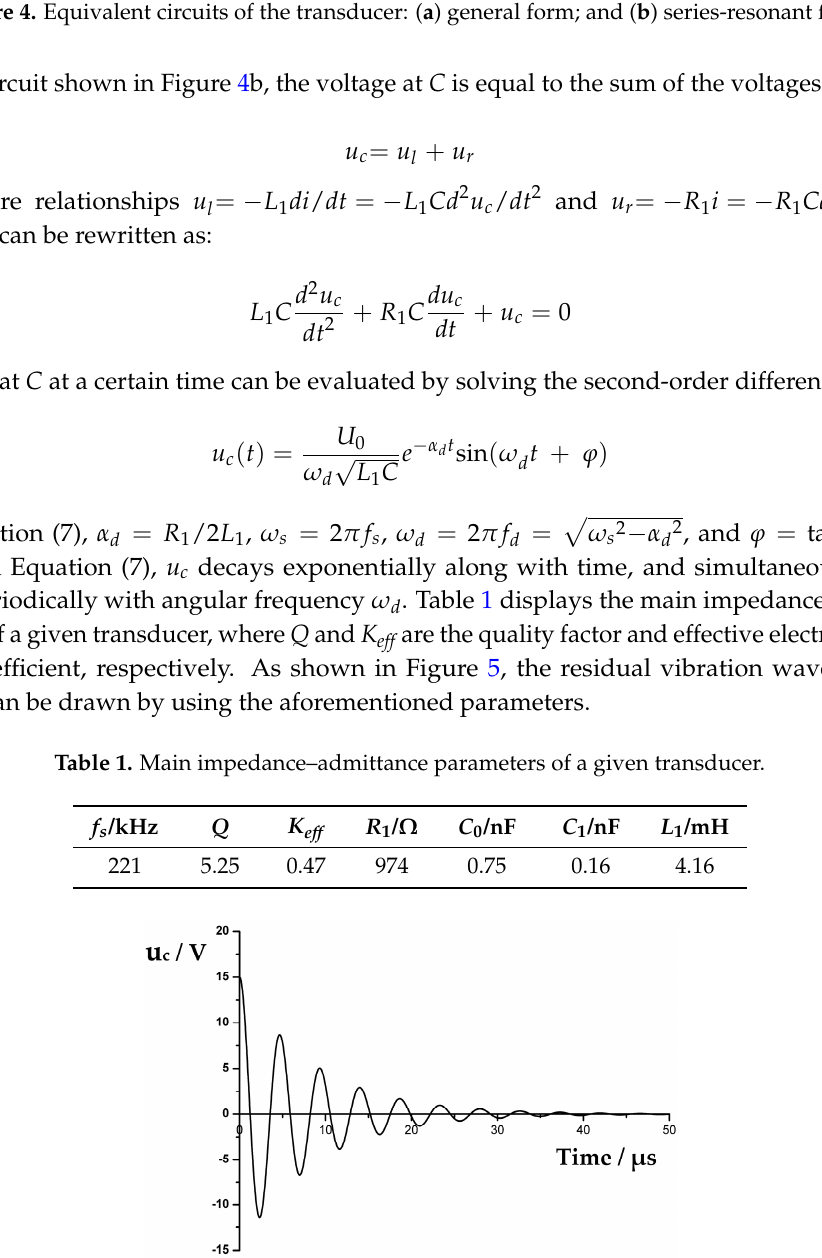
Figure 5. Residual vibration waveform of the transducer.